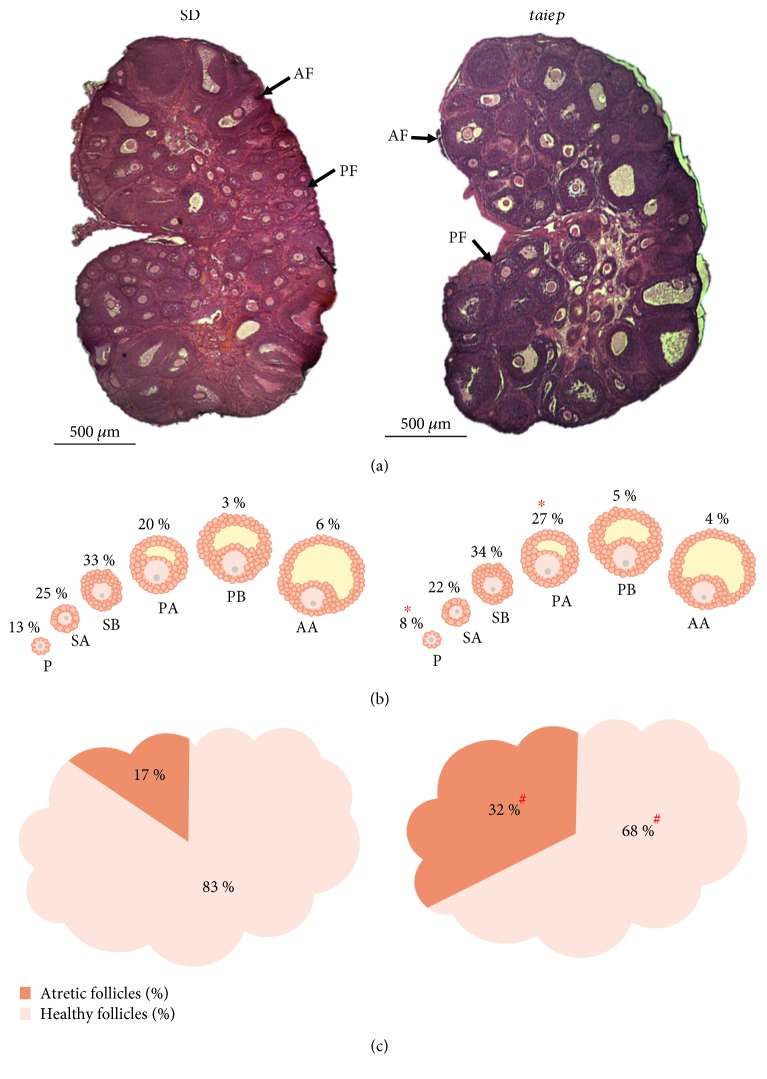
Follicle population in Sprague–Dawley and taiep rats in the juvenile stage. (a) Representative histological slice of the ovary. (b) Percentages of follicles in the different categories. (c) Percentages of total atretic and healthy follicles in the ovary. SD: Sprague–Dawley; AF: antral follicle; PF: preantral follicle; P: primary; SA: secondary A; SB: secondary B; PA: preantral A; PB: preantral B; AA: antral A; AB: antral B. ∗p ≤ 0.01z-test and #p ≤ 0.001z-test.